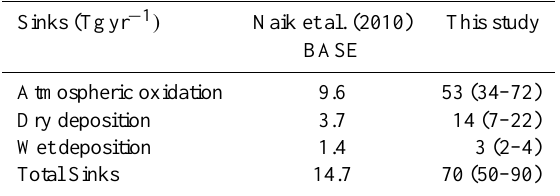
Table 5. Global atmospheric sinks of ethanol in Tg (ethanol)yr − 1 . Numbers in parentheses are the estimated ranges of the sinks. Sinks (Tgyr − 1 ) Naik et al. (2010) This